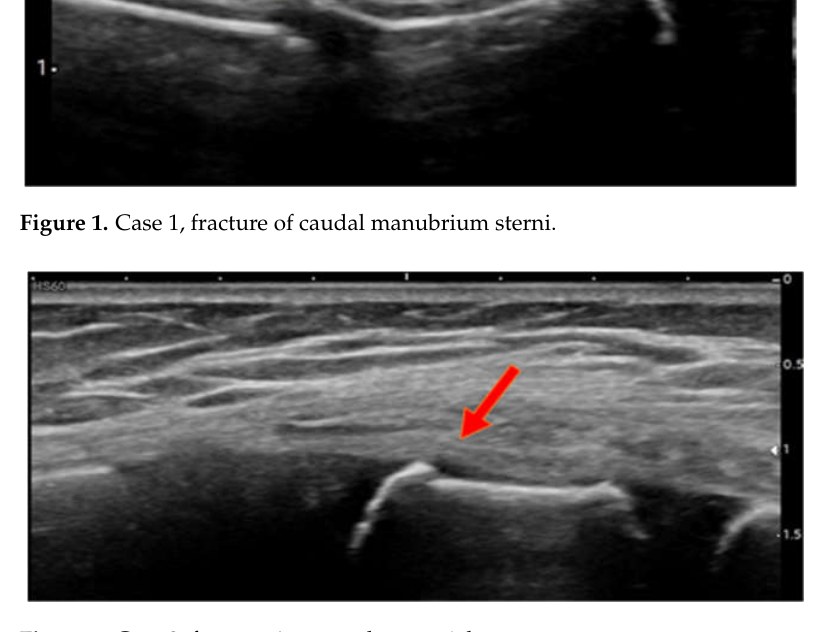
Figure 2. Case 2, fracture 1st sternebra cranial.